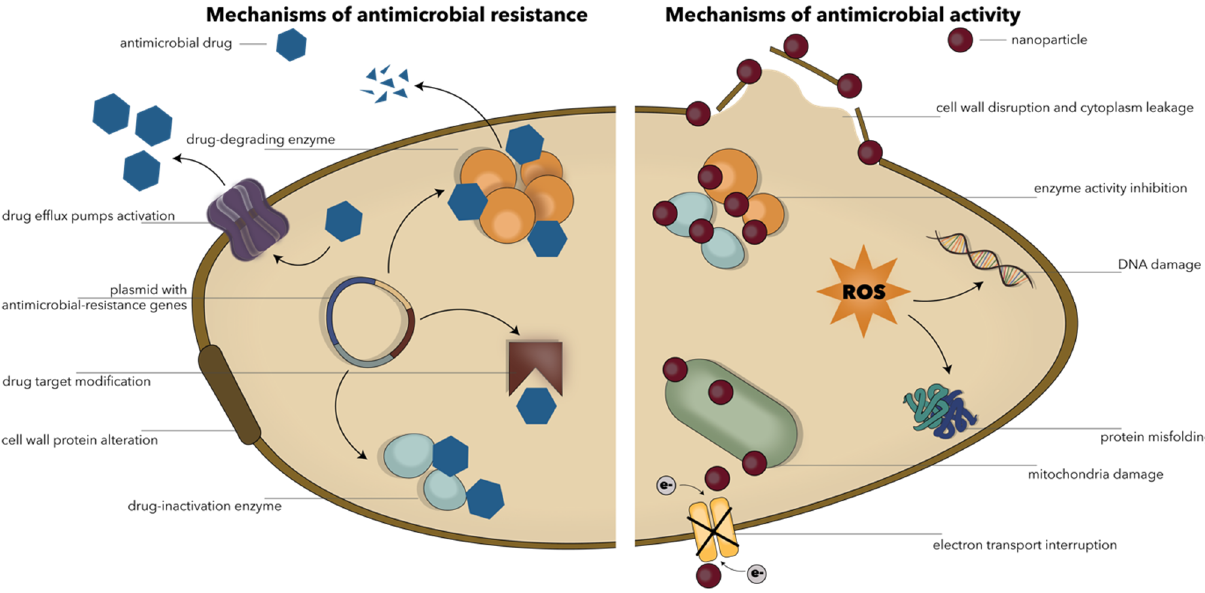
Figure 3. Schematic representation of the main mechanisms involved in the antimicrobial resistance ( left ) and the antimi- crobial activity of NPs ( right ). Reprinted from an open-access source [41].